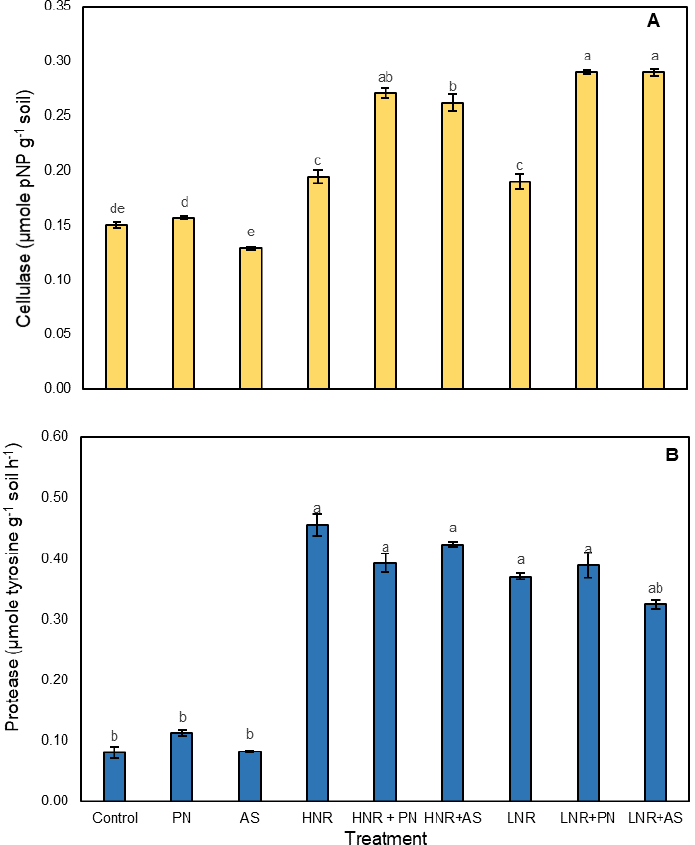
Figure 7. Mean cellulase ( A ) and protease ( B ) activities measured at five intervals (7, 14, 30, 45, and 60 d) during a 60 d aerobic incubation involving an unamended control and the following eight treatments: potassium nitrate (PN), ammonium sulfate (AS), high N residue (HNR) with or without PN (HNR + PN) or AS (HNR + AS), and low N residue (LNR) with or without PN (LNR + PN) or AS (LNR + AS). Data shown as a mean from triplicate incubations with standard error bars. Treatments do not differ significantly ( p < 0.05) when bars are accompanied by the same letter.